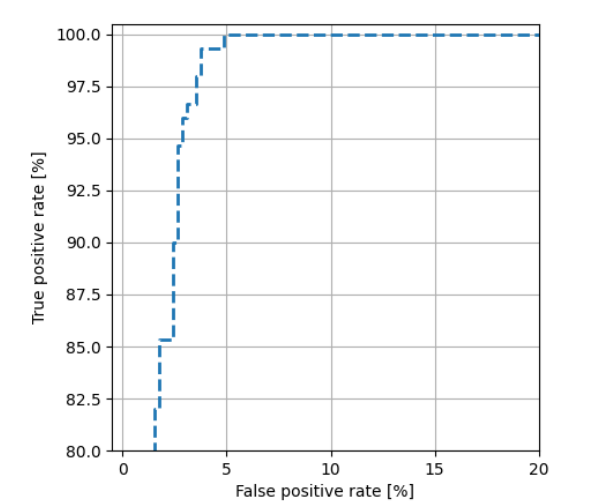
Figure 12. ROC curve for partial fusion classification on the test set. Ranges of TPR and FPR were limited for visualization